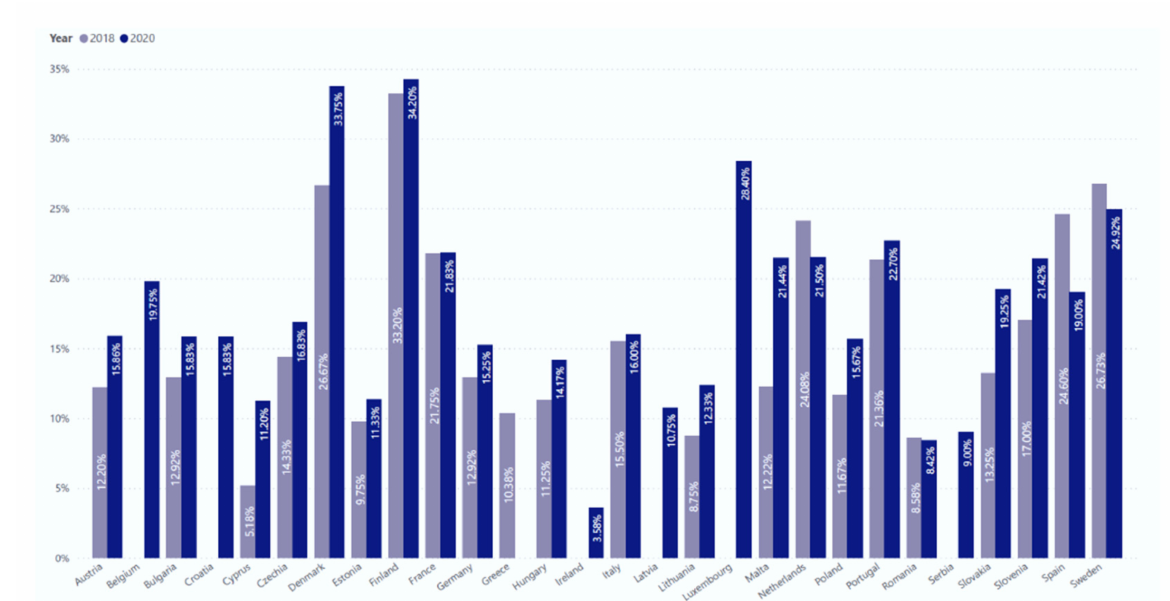
Figure 7. Average share of manufacturing enterprises using industrial robots out of all enterprises using industrial robots, by country, 2020 vs. 2018. Source: Author’s Contribution. Data retrieved from Eurostat. Robotics and 3D Printing Data, https://ec.europa.eu/eurostat/databrowser/bookmark/f2